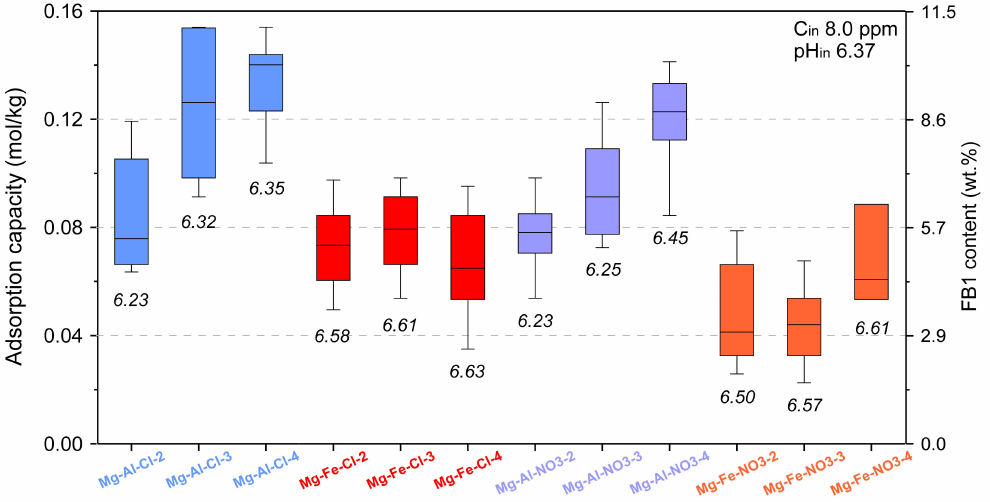
Figure 5. Adsorption capacity of LDH materials tested for 8 ppm